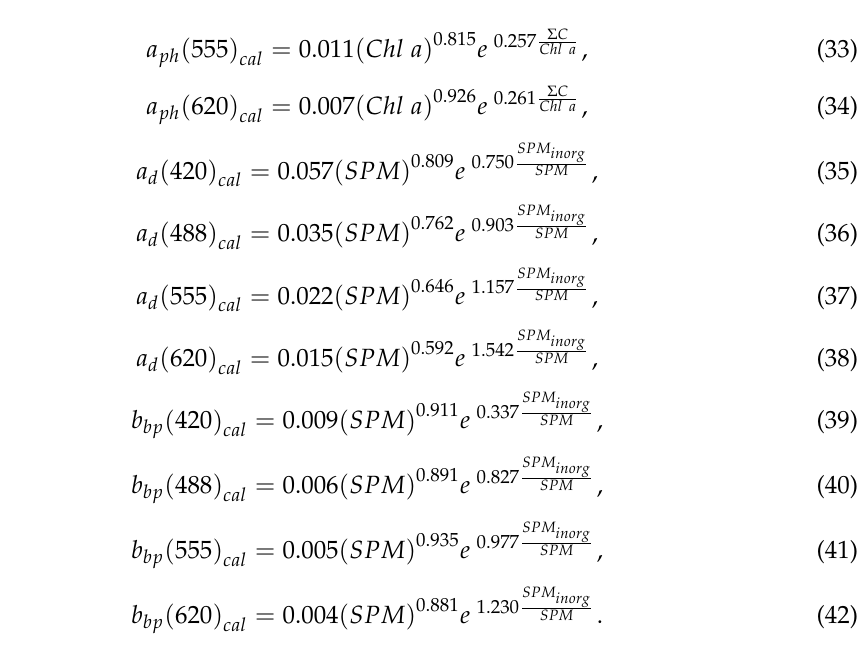
Graphical comparison of the measured empirical values a ph (488) m , a d (488) m and b bp (488) m with their respective values estimated using the two-parameter model of a ph (488) cal , a d (488) cal and b bp (488) cal and ratio distribution histograms ( a ph (488) cal /a ph (488) m ) is presented in Figure 7. Statistical errors (according to linear and logarithmic statistics) of these estimates were also determined (Table 2).